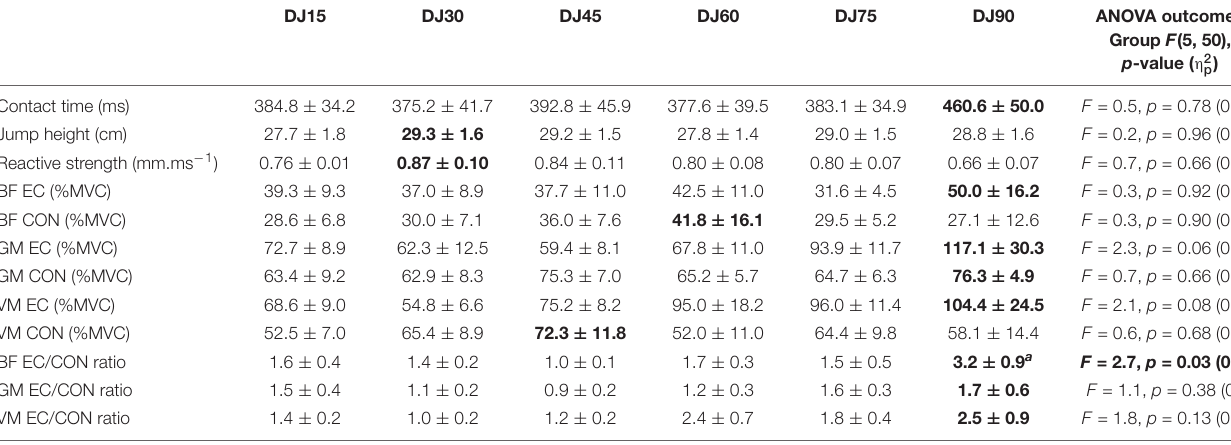
Group F (5, 50), p -value ( η 2 p )